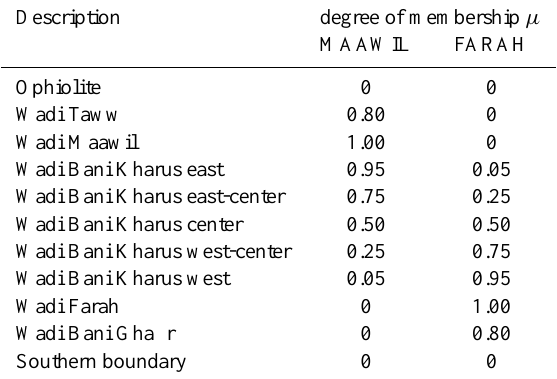
Table 1. Database for interpolation of the fuzzy recharge areas